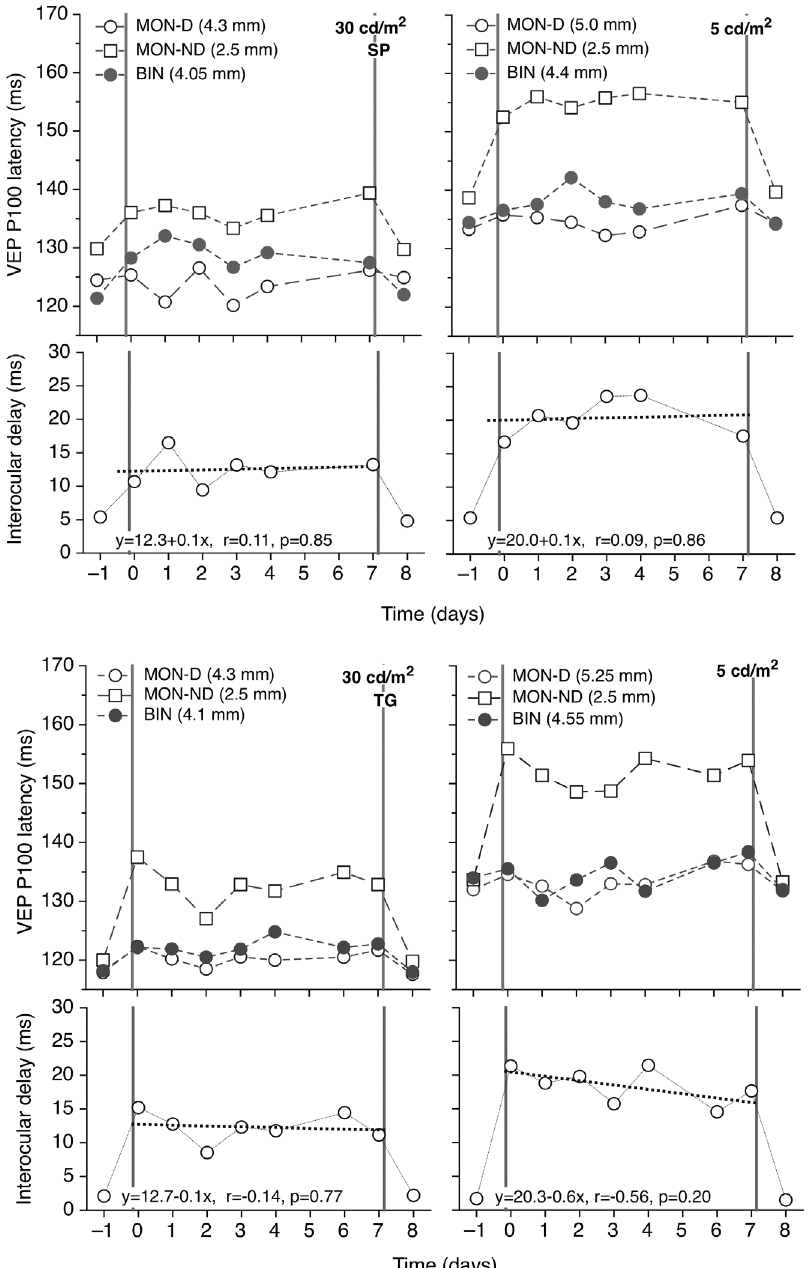
Figure 2. Plots of VEP latency as a function of time for the 2.5 mm aperture contact lens. (upper) Monocular (open circles, dominant eye; open squares, non-dominant eye) and binocular (filled circles) mean latency of the VEP P100 component as a function of time at high (left) and low (right) photopic levels for subjects SP (fig 2a) and for TG (fig 2b). Each point is the average of two recordings. On days -1 and 8 the subject had unobstructed natural pupils. On days 0–7 inclusive the non-dominant (left) eye was wearing a contact lens with an aperture of 2.5 mm in diameter. The dominant eye had its full, unobstructed natural pupil. The legend shows the average pupil size at each condition. (lower) Plot of the interocular latency difference as a function of time. The dotted bold line forms a linear regression for Days 0 to